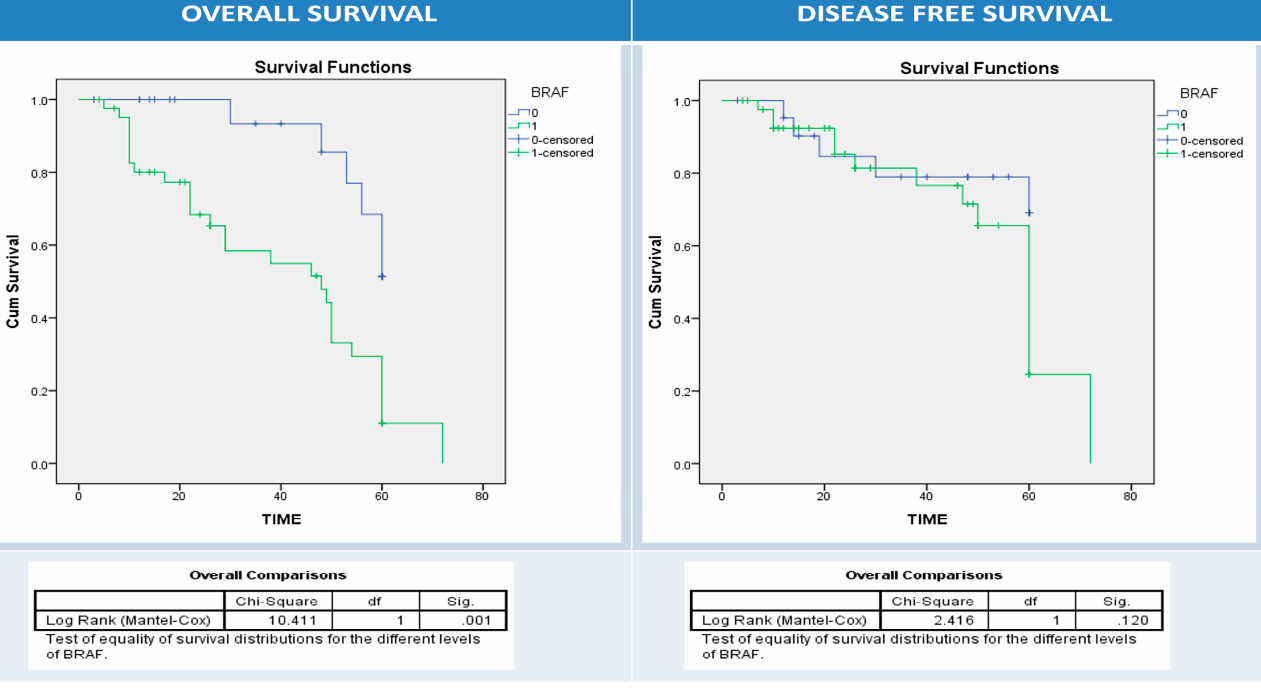
Figure 5. Kaplan–Meier survival curves for overall (right panel) and disease-free survival (left panel) according to BRAF expression (0: blue (-ve BRAF), 1: green (BRAF overexpression)). Log Rank test (Mantel–Cox) was used.